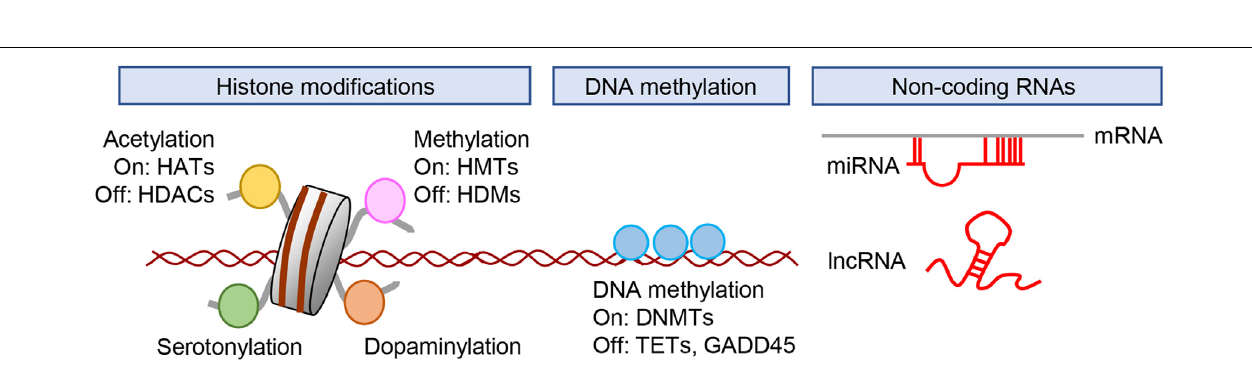
FIGURE 1 | Schematic diagram of the etiology and pathophysiology of psychiatric disorders. Genetic and environmental factors and their interactions modulate brain gene expression in the brain via epigenetic mechanisms. This would lead to circuit dysfunction caused by aberrant synaptic, neural, and structural plasticity, and induce the expression of a variety of symptoms. AAD, alcohol abuse; ASD, autism spectrum disorder; BPD, bipolar disorder; MDD, major depression; SCZ, schizophrenia.